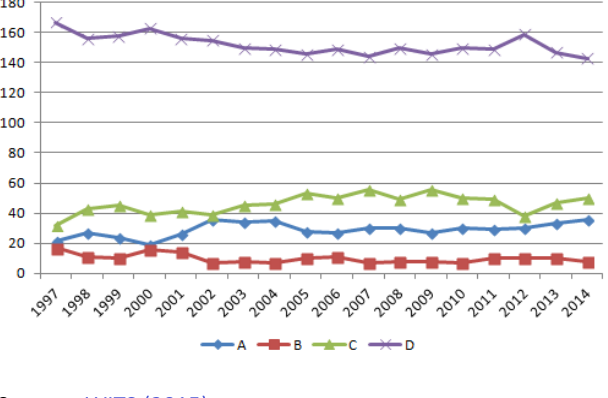
Figure 4: Trends in Number of Products Groups A, B, C and D of Philippines, 1997-2014 Singapore has positive trend for products C (in the past three years) and products A, negative trend for products D and B. Singapore shows significant increasing in comparative advantage and exports specialization.